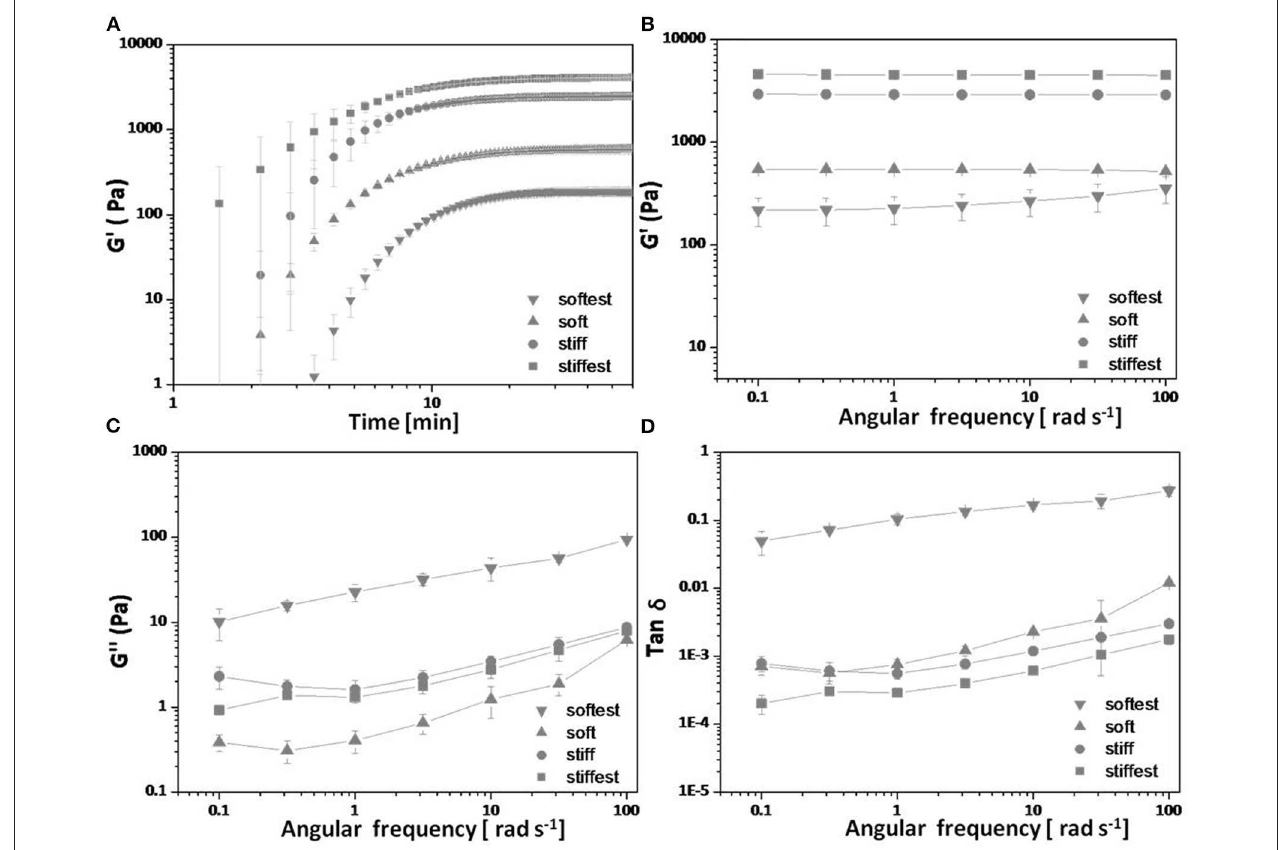
FIGURE 1 | In situ bulk shear rheological measurements on four PAM hydrogel compositions (see Table 1 ): (A) Storage shear modulus G ′ vs. polymerization time, (B) storage shear modulus G ′ vs. angular frequency post-polymerization, (C) loss modulus G ′′ vs. angular frequency post-polymerization, and (D) Tan δ ( = G ′′ /G ′ ) vs. angular frequency post-polymerization. All data points are averages ( ± SD) over three samples measured per composition.